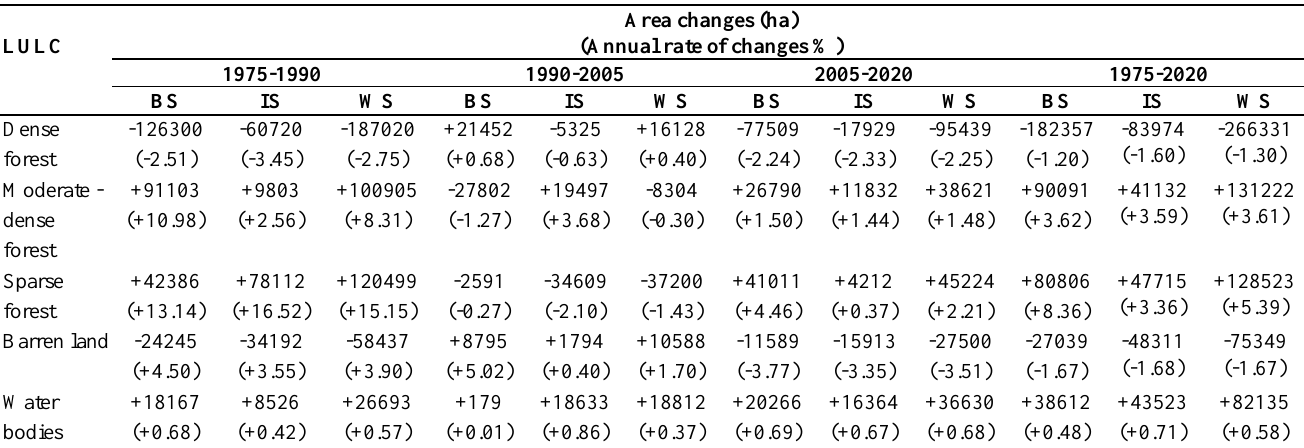
Table 3. Analysis LULC changes of Sundarbans from 1975 - 2020. The analysis was based on estimating net and annual rate changes between two